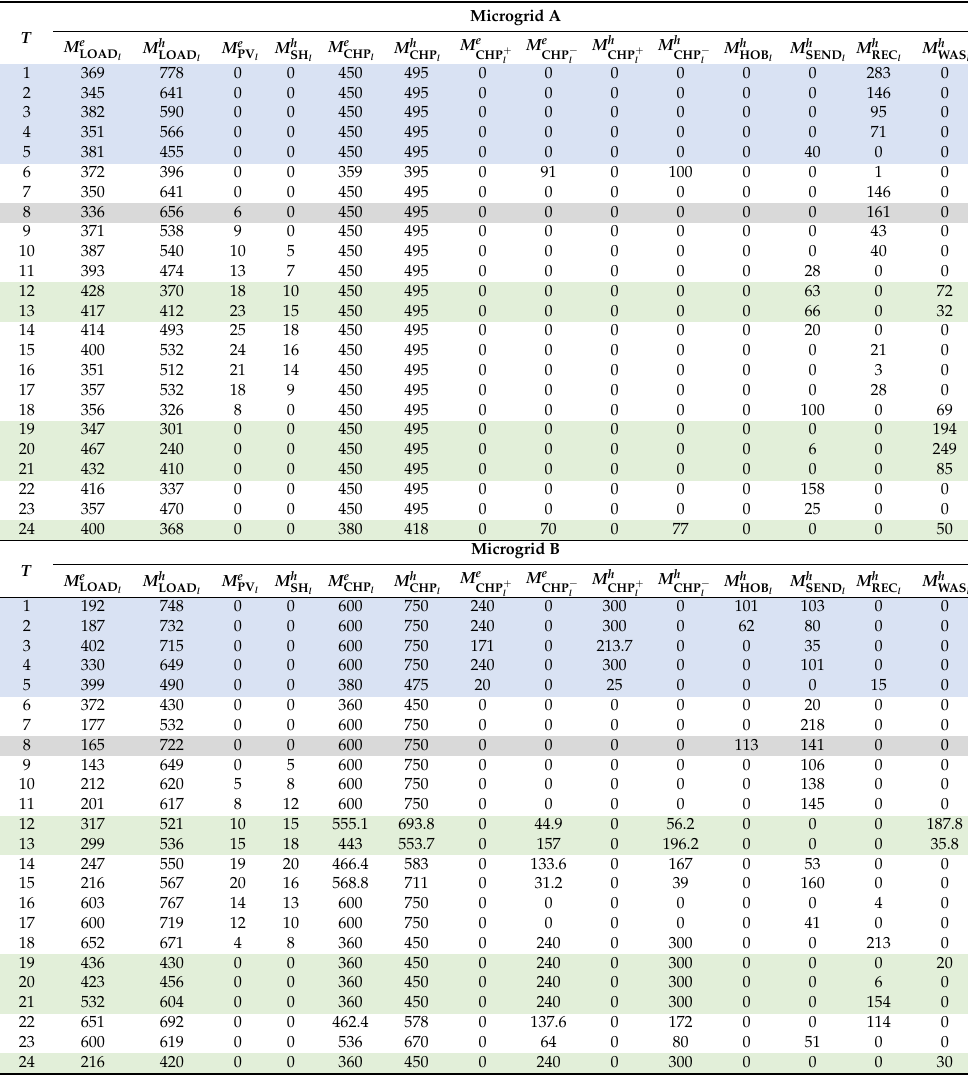
Table 5. Global optimization of heat energy in Step